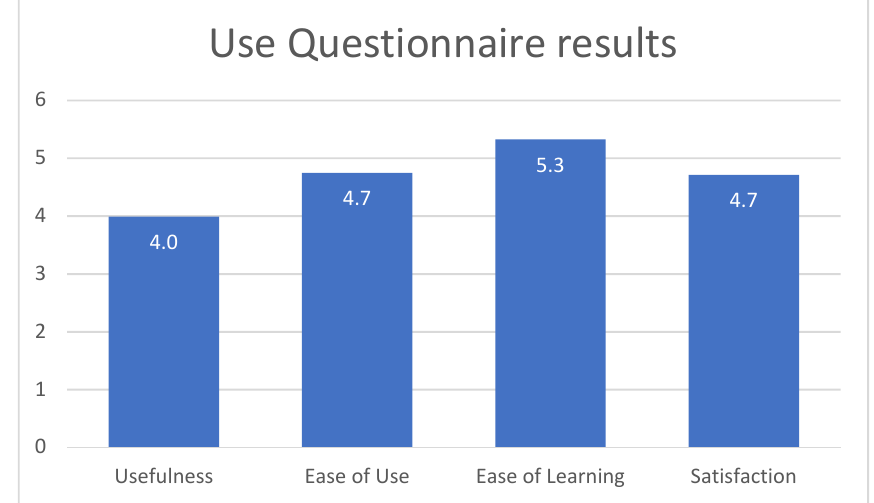
Figure 4. USE questionnaire results.